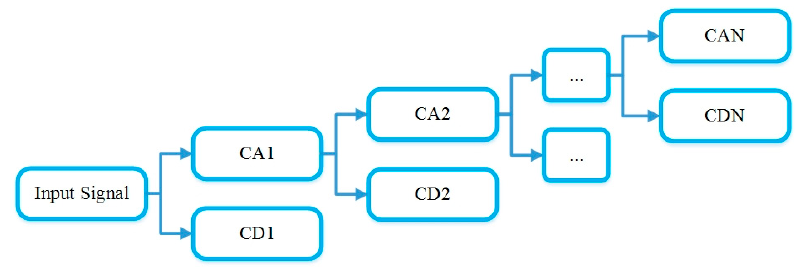
Figure 3. Decomposition of a signal into approximate and detailed components. TheECGdenoisingapproachinthisstudyiscomposedofthreestages: